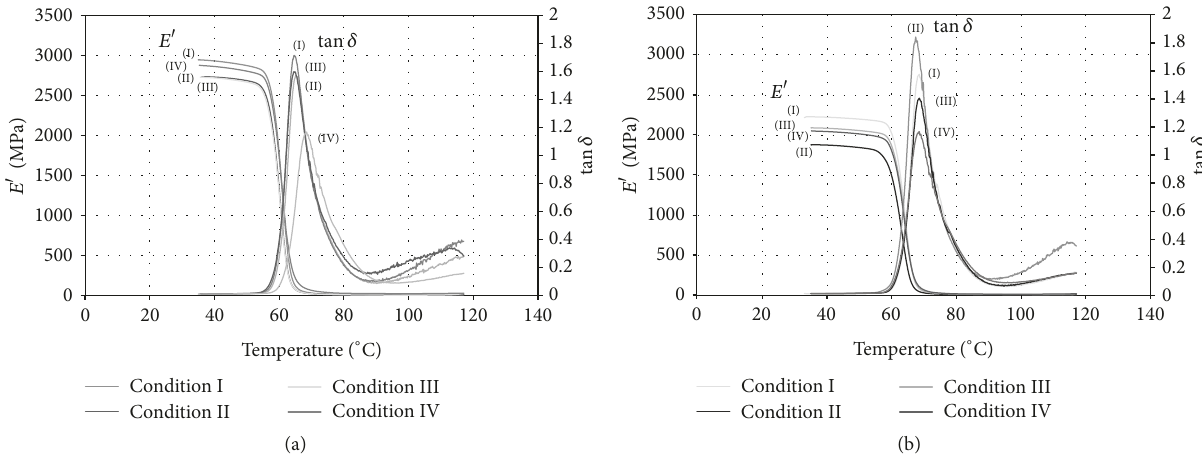
Figure 5: Storage modulus and loss tangent as a function of temperature for PLGA specimen injection molded under different conditions (I, II, III, and IV). Curve for unnotched (a) and notched (b) specimens.